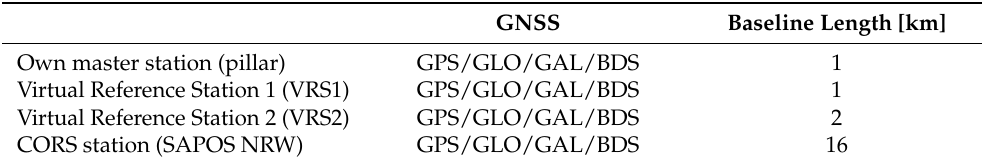
Table 4. GNSS master stations used for trajectory estimation of single strip measurements for experiment